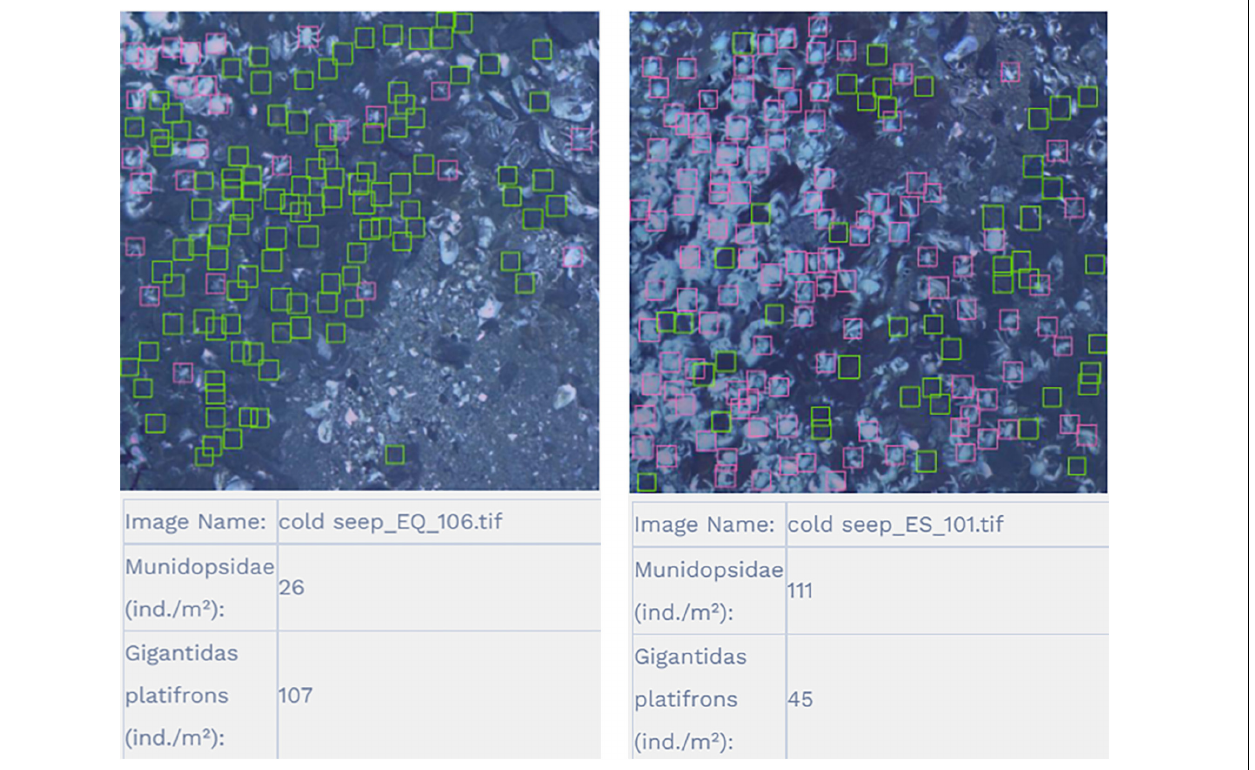
FIGURE 5 | Recognition results for G . platifrons and Munidopsidae as represented as green and pink frames, respectively. TABLE 5 | Experimental results of the substrates on the test set where (B) to (H) represent the different substrates defined in Table 1 . Category